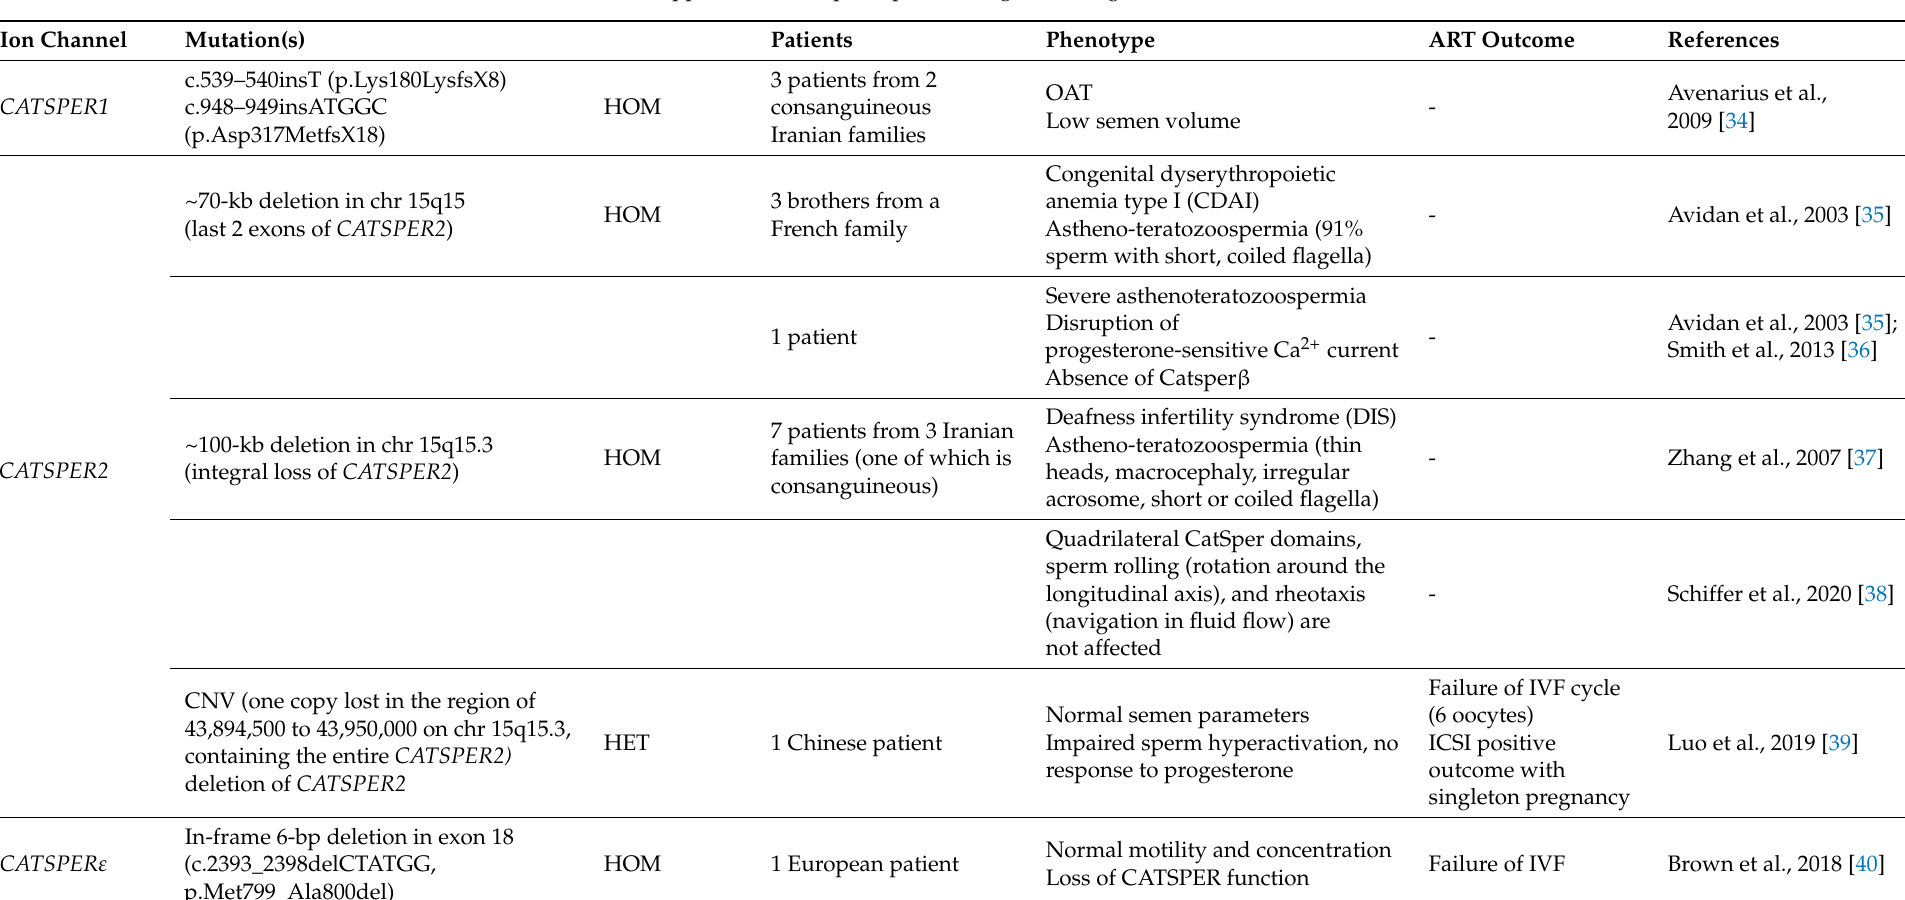
Table 1. Pathogenic variants in genes encoding ion channels or transporters and associated with asthenozoospermia and male infertility in humans, AST, asthenozoospermia; OAT, oligo-astheno-teratozoospermia; AZOO, azoospermia; HET: heterozygous; HOM: Homozygous; ICSI, intracytoplasmic sperm